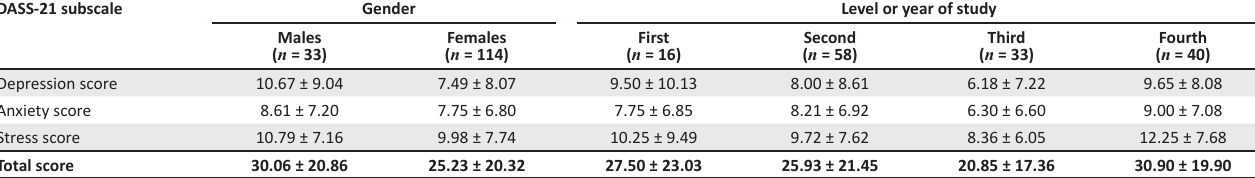
TABLE 2: Depression Anxiety Stress Scale-21 scores (means and standard deviations) stratified for gender and level of study. DASS-21